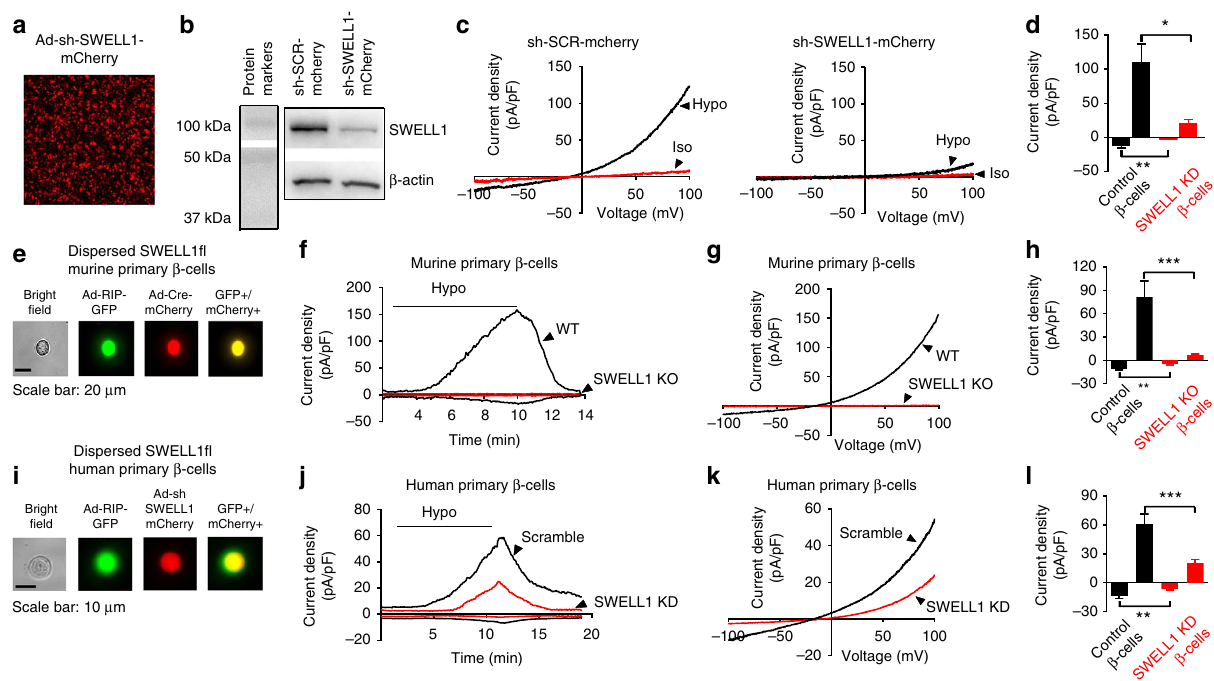
Fig. 1 SWELL1 mediates I Cl,SWELL in MIN6 cells and primary mouse and human pancreatic β -cells. a mCherry fl uorescence of the mouse insulinoma cell line (MIN6) transduced with an adenovirus expressing a short hairpin RNA directed to Swell1 (sh Swell1 -mCherry). b SWELL1 western blot in MIN6 cells transduced with sh Swell1 compared to scrambled short hairpin RNA (shSCR). β -actin was used as loading control (Supplementary Fig. 6a for full blots). c Current – voltage relationship of I Cl,SWELL in MIN6 cells at baseline (red) and after hypotonic swelling (Hypo, 210 mOsm/kg, black) after adenoviral transduction with shSCR (left) and sh Swell1 (right). d Mean current inward and outward densities at +100 and − 100 mV ( n shSCR = 3 cells; n shswell1 = 4 cells). e Bright fi eld, GFP, mCherry, and merged images of freshly dispersed primary β -cells from Swell1 fl / fl mouse islets co-transduced with Ad-RIP2-GFP and Ad- CMV-Cre-mCherry. Scale bar represents 20 µ m. f , g Current – time relationship ( f ) and current – voltage relationship ( g ) of swell-activated I Cl,SWELL in wild- type (WT: Ad-CMV-mCherry/ Swell1 fl / fl ) and Swell1 knockout (KO: Ad-CMV-Cre-mCherry/ Swell1 fl / fl ) mouse primary β -cells. h Mean current inward and outward densities at +100 and − 100 mV ( n = 5 cells, each group). i Bright fi eld, GFP, mCherry, and merged images of freshly dispersed primary β -cells from human islets co-transduced with Ad-RIP2-GFP and Ad-sh Swell1 -mCherry. Scale bar represents 10 µ m. j Current – time relationship and k current – voltage relationship of swell-activated I Cl,SWELL in WT and SWELL1 knockdown primary human β -cells. l Mean current inward and outward densities at +100 and − 100 mV ( n = 5 cells; n = 10 cells). Ramp protocol is from +100 mV to − 100 mV (ramp duration: 500 ms, holding potential: 0 mV). Data are shSCR shswell1 shown as mean ± s.e.m. * p < 0.05; ** p < 0.01; *** p < 0.001, unpaired t- test for d , h , response to 16.7 mM glucose in WT and Swell1 KO murine β - cells at 37 °C in perforated patch con fi guration (Fig. 3g), similar to recording conditions used to measure glucose-stimulated SWELL1 currents shown in Fig. 2. WT and Swell1 KO β -cells have comparable resting MP (Fig. 3h) while glucose-stimulated β - cell membrane depolarization rate is signi fi cantly reduced 2.6- fold in Swell1 KO β -cells (Fig. 3i). Collectively, these data show that SWELL1-mediated I Cl,SWELL contributes a signi fi cant glucose-stimulated depolarizing current in β -cells. β -cell SWELL1 is required for glucose and swelling-induced Ca 2+ signaling . Having established that SWELL1-mediated I Cl, fi cantly to both glucose and hypotonic SWELL contributes signi swell-activated β -cell membrane depolarization, we next sought to examine intracellular Ca 2+ signaling in WT and SWELL1- de fi cient MIN6 β -cells, primary mouse and primary human β - cells in response to these stimuli. Using CRISPR/Cas9 technology, we generated multiple Swell1 KO MIN6 cell lines (Supplementary Fig. 3), con fi rming Swell1 gene disruption by PCR (Supplemen- tary Fig. 3), SWELL1 protein deletion (Fig. 4a and Supplementary Fig. 6b) and ablation of SWELL1-mediated current (Fig. 4b) in these cells. We fi nd that glucose-stimulated Ca 2+ transients are entirely abolished in Swell1 KO MIN6 compared to WT cells